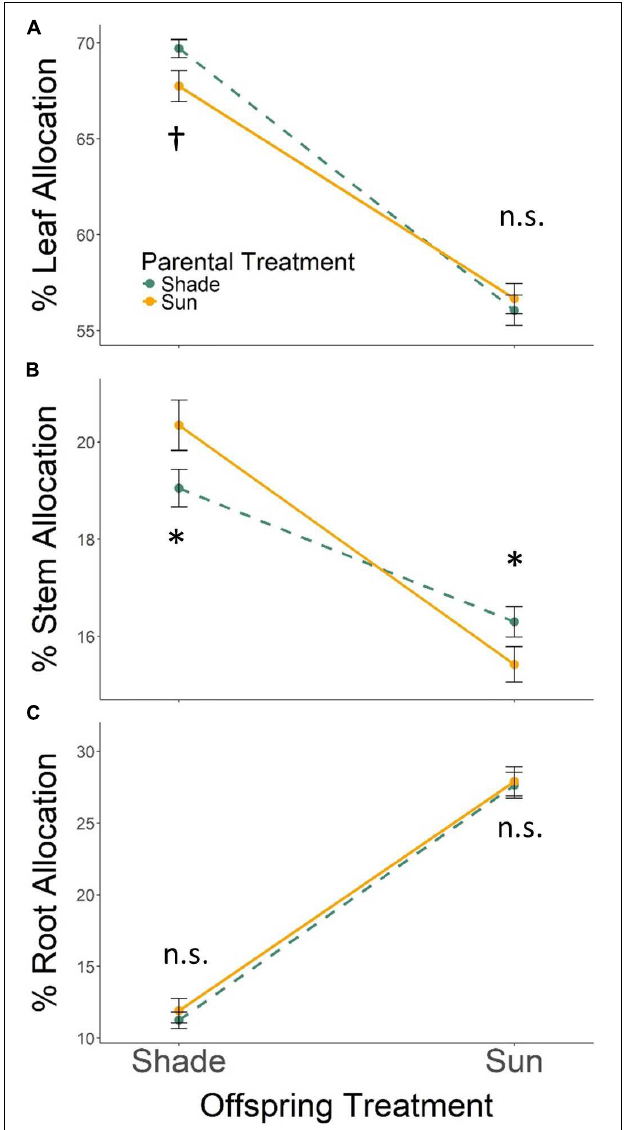
FIGURE 2 | Means ± SE shown ( N = 184) for (A) % leaf, (B) % stem, and (C) % root biomass allocation for offspring of Parental Shade (dashed green line) and Parental Sun (solid yellow line) plants that were grown either in Offspring Shade or Offspring Sun treatments. Results of significant tests for the effect of parental shade versus sun in each offspring treatment are shown, based on separate within-treatment ANOVAs ( † p < 0.10, ∗ p < 0.05, n.s. p > 0.1, see section “Materials and Methods” for